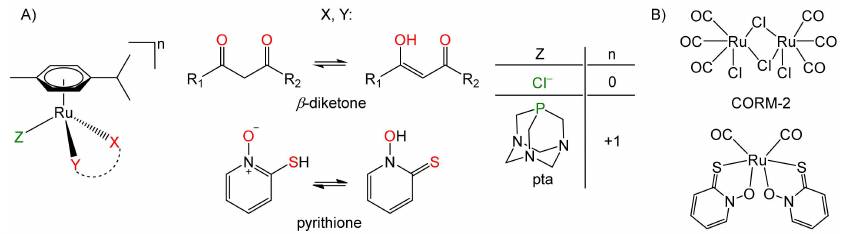
Figure 1. ( A ) p -Cymene-containing organoruthenium(II) complexes; ( B ) Organoruthenium(II) car- bonyl complexes as CO-releasing molecules (CORM − 2; i.e., [Ru(CO) 3 Cl 2 ] 2 ). Atoms labelled in red and green represent the donor atoms through which the ligands are bound to the ruthenium ion.